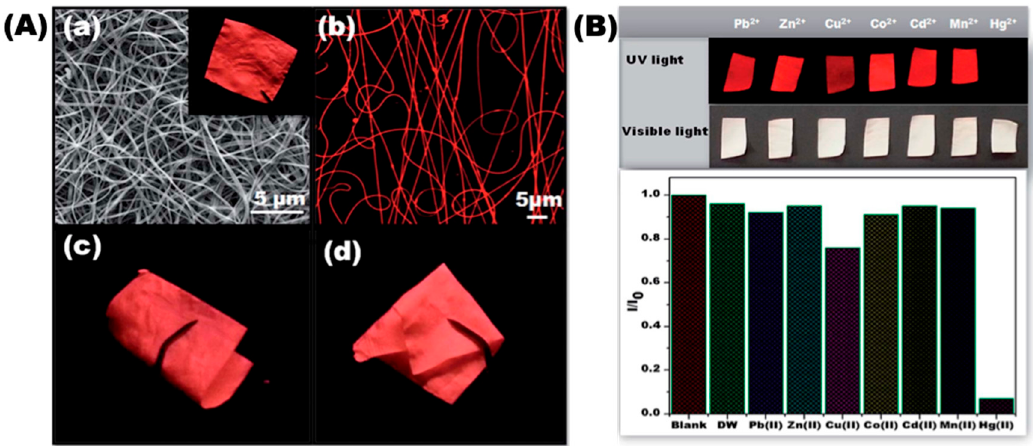
Figure 6. ( A ) SEM image of the cross-linked AuNC*NFM ( a ). Inset shows a photograph taken under UV light. ( b ) CLSM image of the AuNC*NF. ( c , d ) Flexible nature of the nanofibrous membrane. ( B ) Sensing performance of AuNC*NFM upon exposure to di ff erent metal ions in water. The concentration of